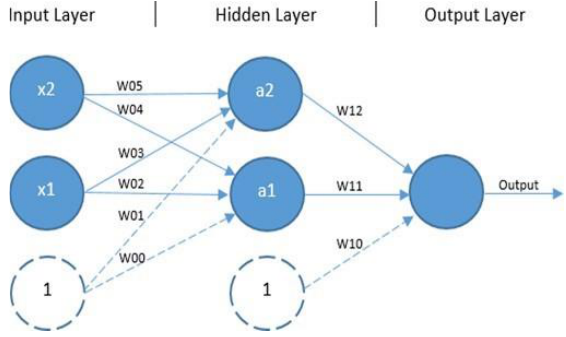
Fig. 3 Structure of Backpropagation Algorithm